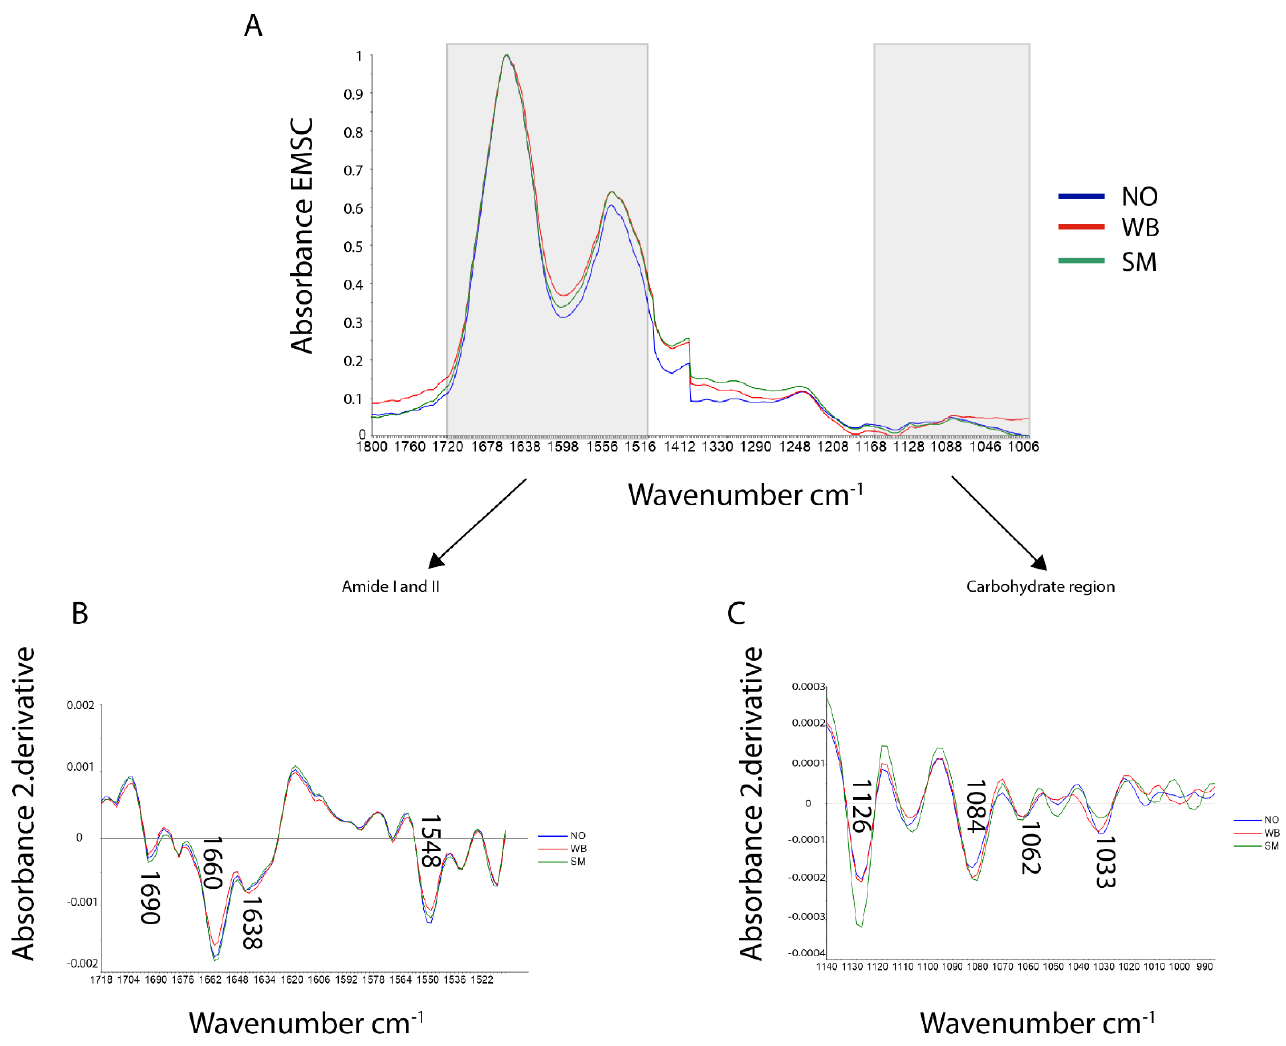
Figure 3. ( A ) FTIR spectra (averaged and EMSC corrected) collected from the connective tissue in NO, WB, and SM chicken fillet (1800 – 1000 cm −1 ) ( B ) Savitzky Golay’s second derivative spectra of NO, WB, and SM fillets in the Amide I & II region (1718 – 1492 cm −1 ) and ( C ) carbohydrate region (1140 – 985 cm −1 ).